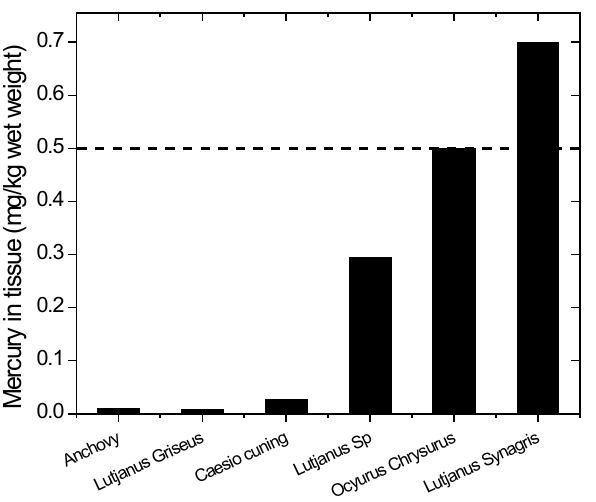
Figure 7. Mercury content in species of fish from Wubudu Estuary. The dashed line indicates the recommended safety level (WHO/ICPS